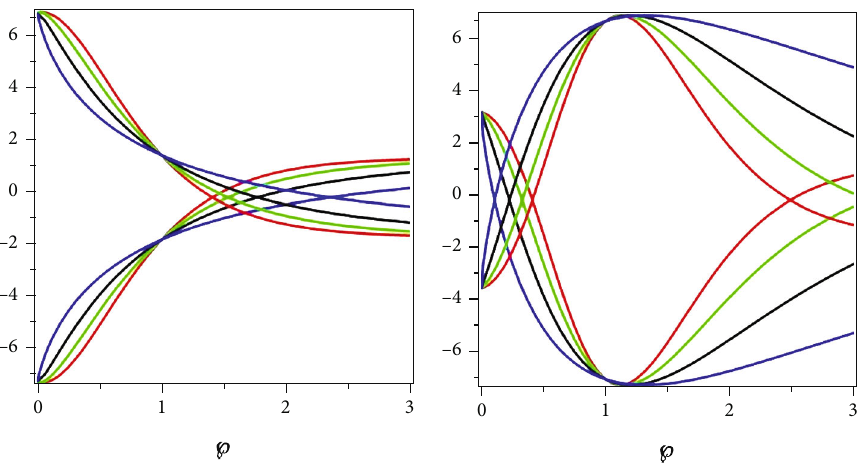
Figure 4: (a) 2D upper and lower fuzzy branch plots with respect to time and (b) di ff erent fractional-order of ς